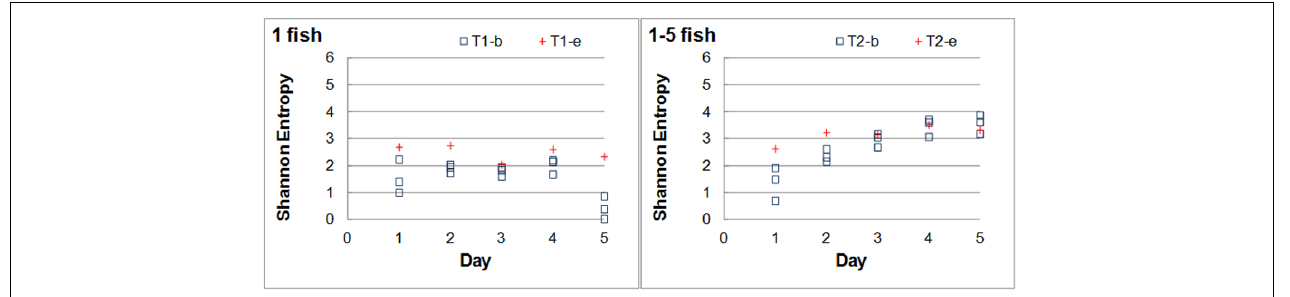
FIGURE 6 | Daily evolution of the Shannon entropy in Experiment B. Tank 1 (Left plot) contained only one fish, but a different fish every day, during the 5 experimental days. The number of fish in Tank 2 (Right plot) increased by one individual daily. The number of fish is indicated on the Top-Left of the panels. The square markers correspond to the SE values for the basal states and the crosses to the SE in response to the event.